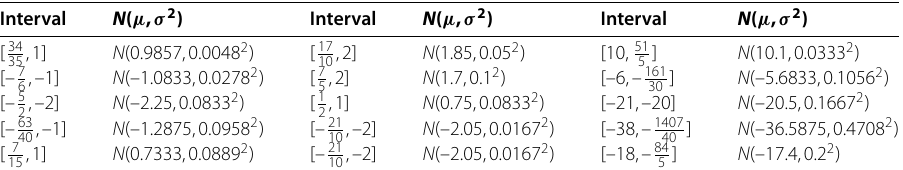
Table 2 Normal distributions corresponding to interval coefficients in all the constraints of Example 2